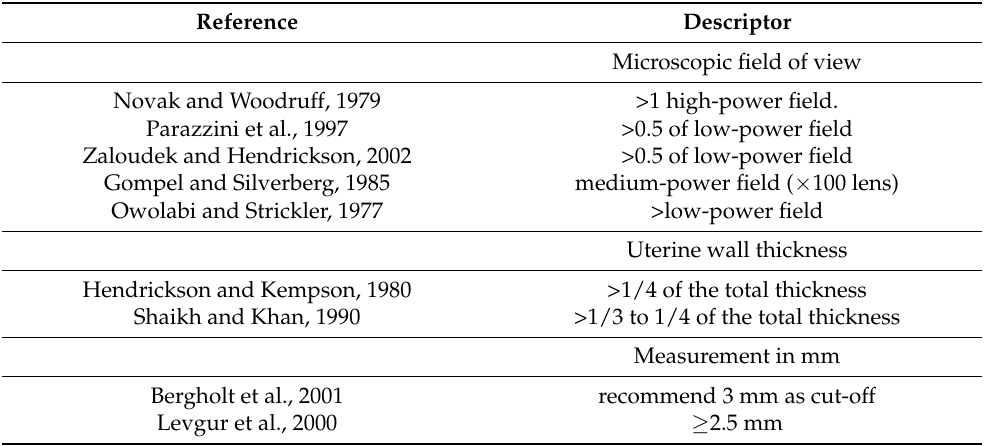
Table 1. The histological cut-off point adopted for the diagnosis of adenomyosis in different